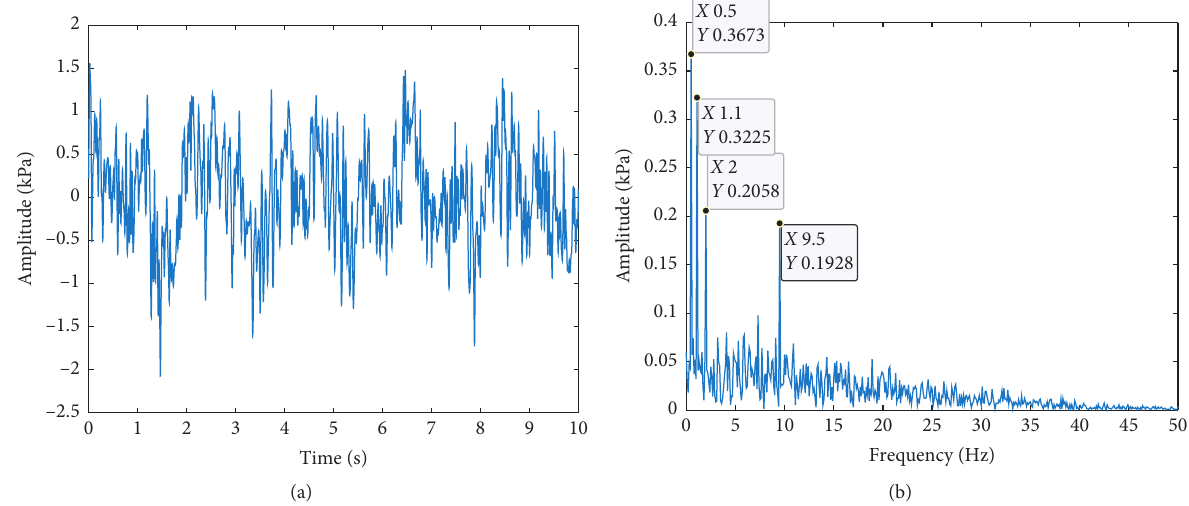
Figure 4: Waveform and spectrum diagram after ALIF noise reduction. (a) Waveform diagram. (b) Spectrogram.